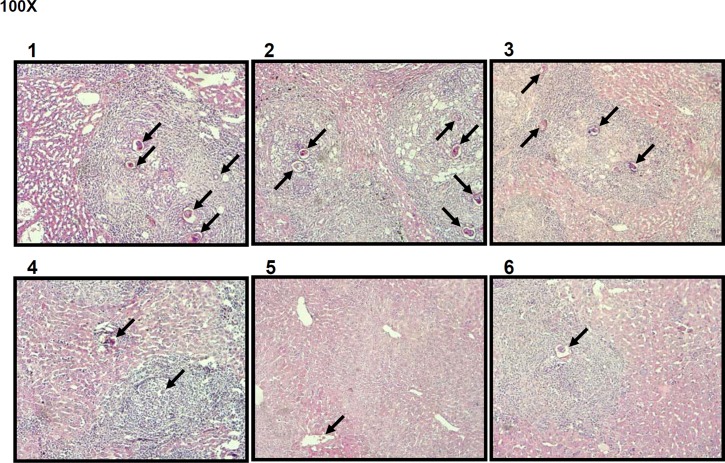
Histopathology of liver tissue sections of mice in different groups.Vaccination with a combination of pcDNA/SjGST vaccine, IL-12 plasmid, and recombinant SjGST protein reduced egg deposition and egg-induced granulomas. The numbers 1–6 above the images represent Group I-VI of mice, respectively. Group V and VI showed fewer inflammatory cells in the liver tissue. Paraffin-embedded liver tissues from S. japonicum-infected mice were stained using H&E. Tissue images were captured with a microscope (Leica) under 100 × magnifications. Sites of egg deposition are shown with arrows.